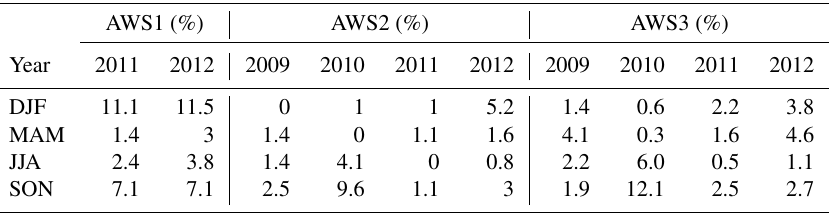
Table 2. The percentage of time in which 6-hourly föhn conditions were identified from both AWS observations and AMPS. Values are taken from Turton et al. (2018) and presented here because the frequency of föhn conditions is important for the discussion. SON is spring; DJF is summer; MAM is autumn; and JJA is winter. Refer to Table 1 for information on data gaps. Percentages represent the ratios between föhn conditions and the total duration of non-missing data. December values are taken from the preceding year, to keep within the same melting season (for example DJF 2012 spans 1 December 2011 to 29 February 2012).